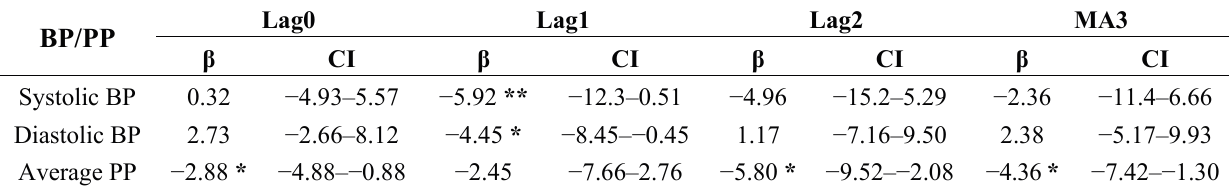
Table 7. Mean change and 95% confidence interval (CI) in blood (BP) and pulse pressure (PP) per 10 4 particles/cm 3 in PNC (Lag0, Lag1, Lag2, and 3-day moving average (MA3)) after adjustment for baseline blood and pulse pressure,